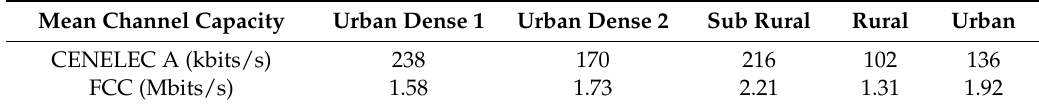
Table 2. Mean channel capacity value per site.